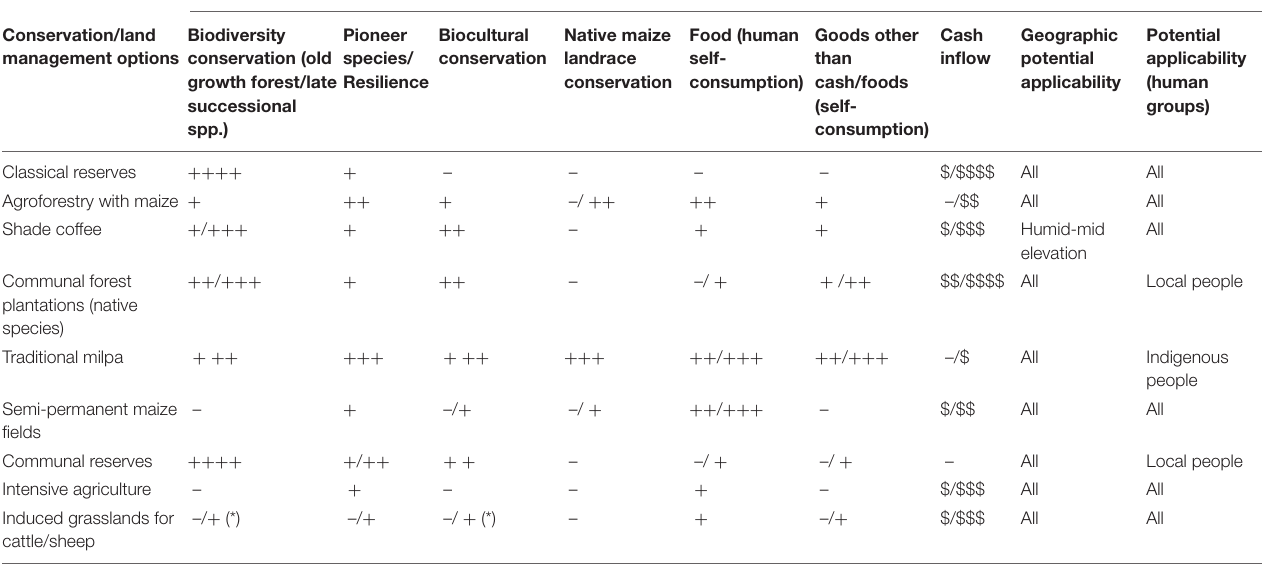
TABLE 3 | Comparative of selected conservation and management options currently applied in SMP mountains regarding their conservation potential, resilience, biocultural conservation, the potential for providing foods and other goods for human self-consumption (low, + , to very high, ++++ ), cash inflow ($, low to very